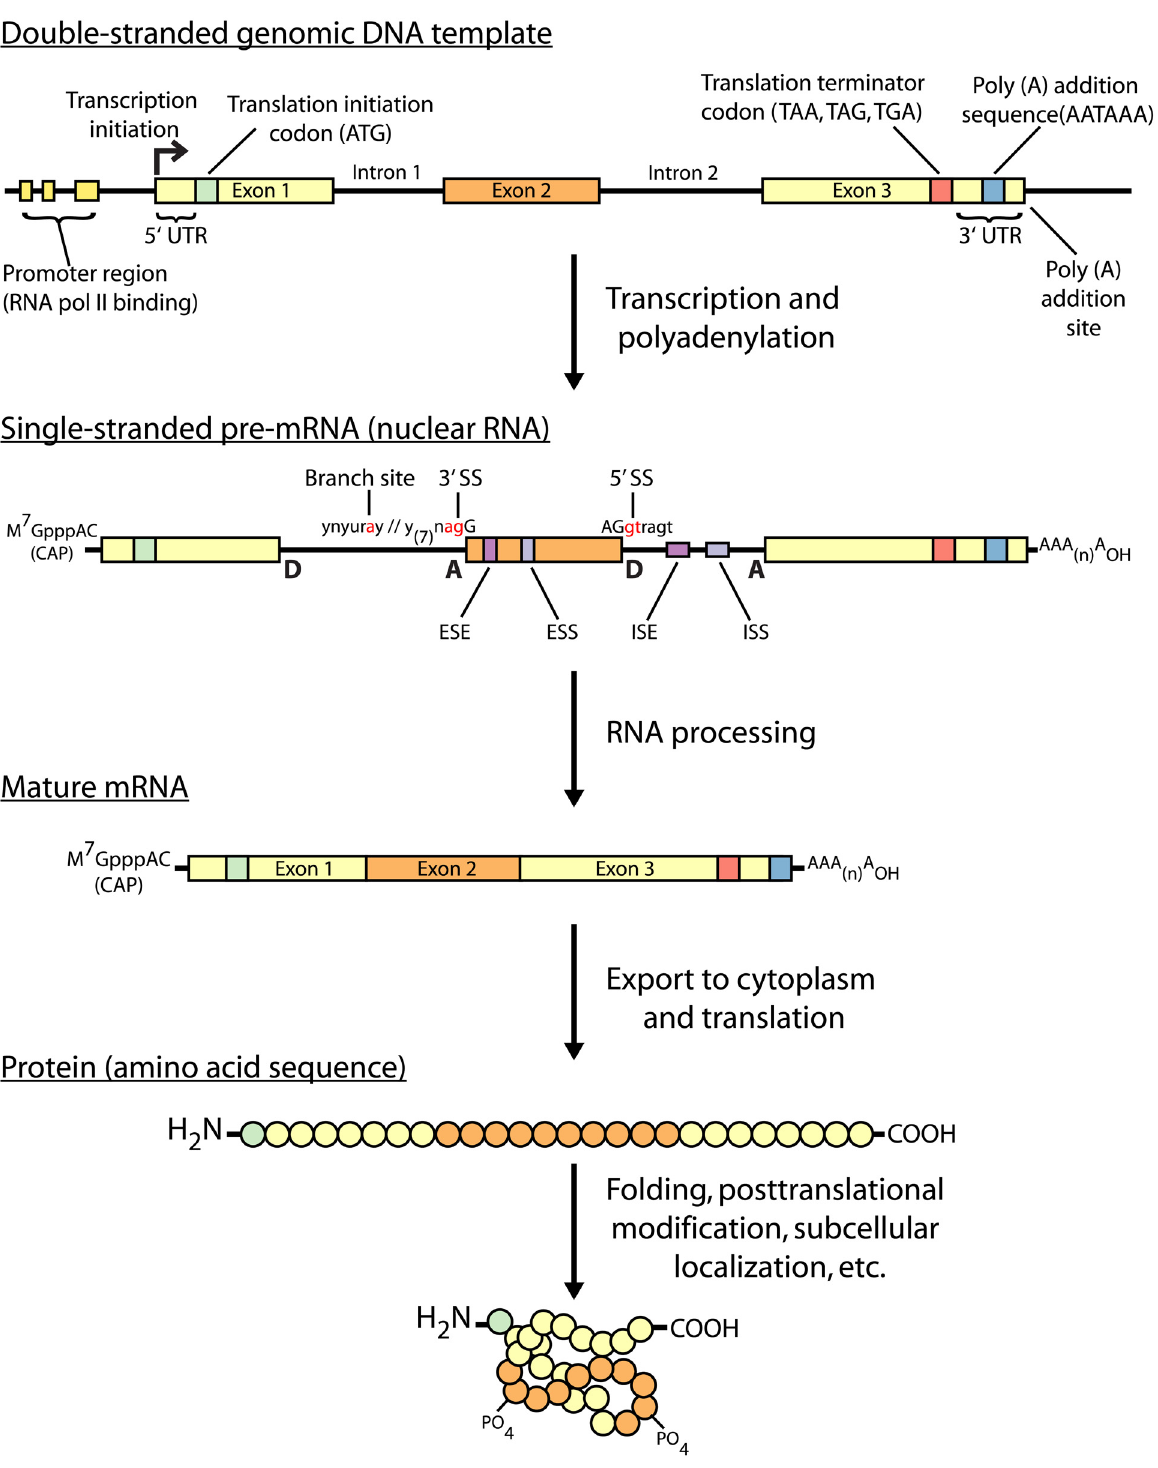
Fig 1. An overview of the central dogma of molecular biology. The flow of genetic information from double-stranded genomic DNA template to post- translationally modified proteins is depicted with molecular features critical to each stage enumerated. RNA-seq typically targets the mature mRNA molecules. Abbreviations: donor splice site (D); acceptor splice site (A); polyadenylation (poly (A)); untranslated region (UTR); splice site (SS); exonic splicing enhancer (ESE), exonic splicing silencer (ESS), intronic splicing enhancer (ISE); intronic splicing silencer (ISS).